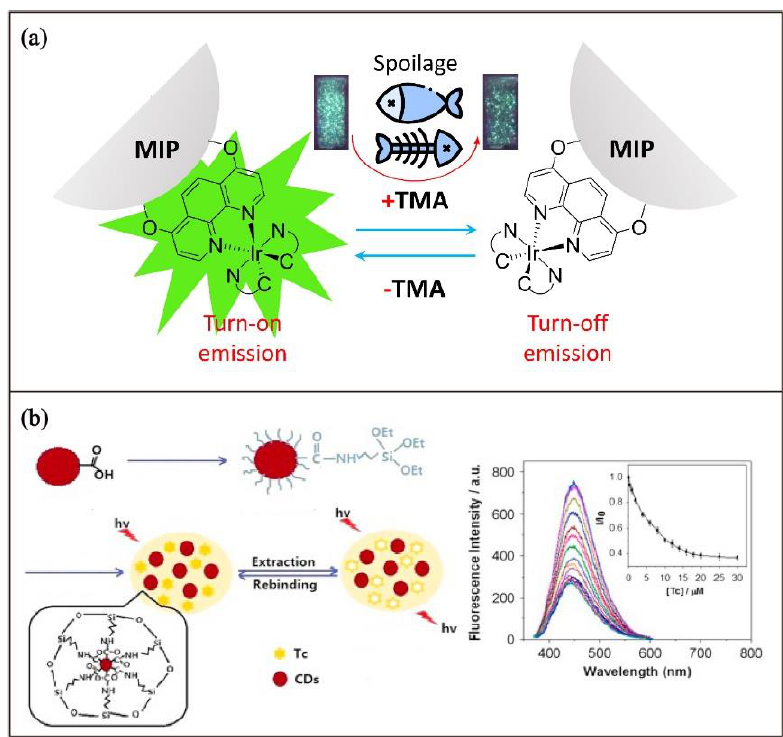
Figure 12. Schematic illustration of ( a ) the luminescent MIP sensor PTMA-Ir for selective detection of TMA released in spoiled seafood. ( b ) Preparation and fluorescence spectral changes of MIP grafted on carbon QDs for selective detection of trace tetracycline in milk. Adapted with permission. [142] Copyright 2016, Elsevier.